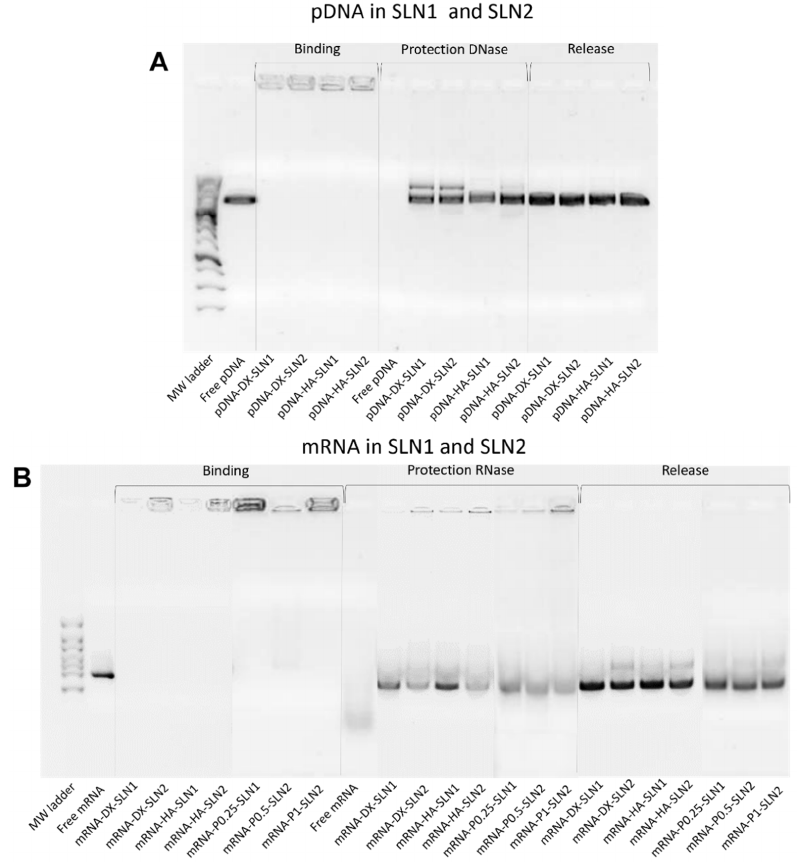
Figure 2. Binding, protection and release capacity of pDNA- and mRNA-based vectors: ( A ) pDNA-SLN1 and pDNA-SLN2 vectors; ( B ) mRNA-SLN1 and mRNA-SLN2 vectors.